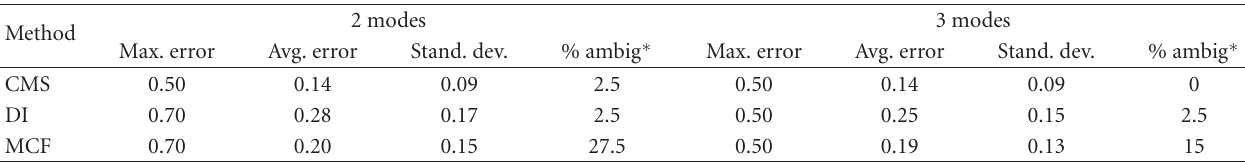
Figure 15: Change in flexibility calculated using the first three flexural modes for numerical damage case 7, located 0.97 m from the support, using (a) 7 and (b) 15 simulated measurement points. Table 5: Error in predicted damage location by each method, listed as a fraction of measurement point spacing, when two and three modes were used in combination with 15 measurement